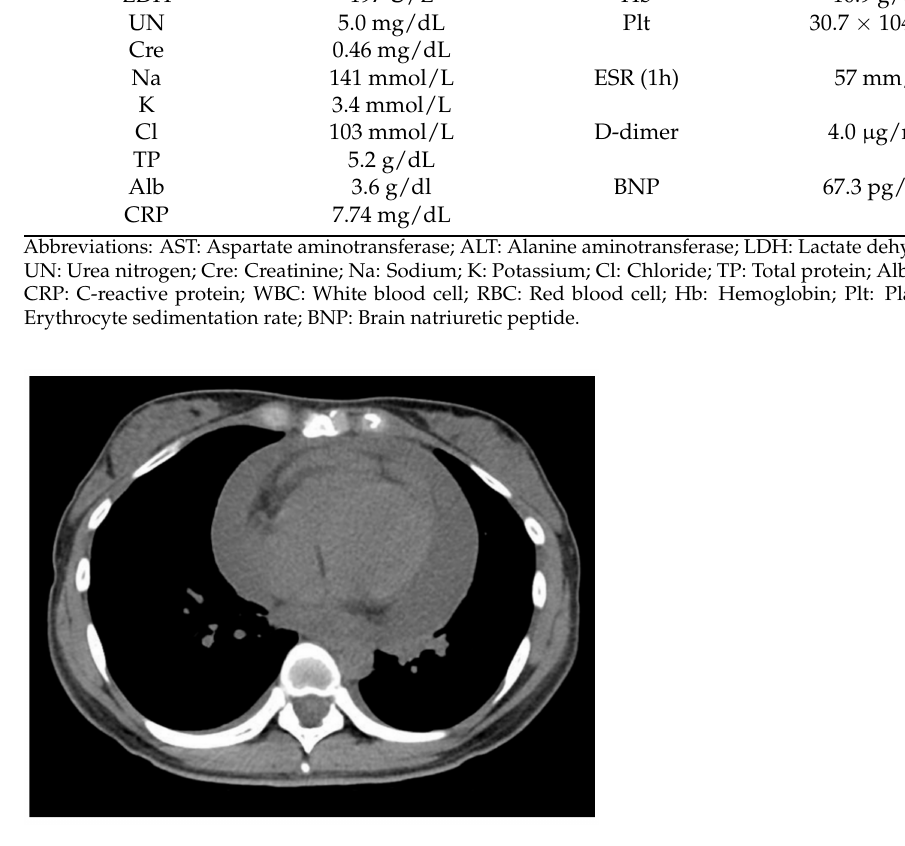
Figure 2. A computed tomography showing pericardial